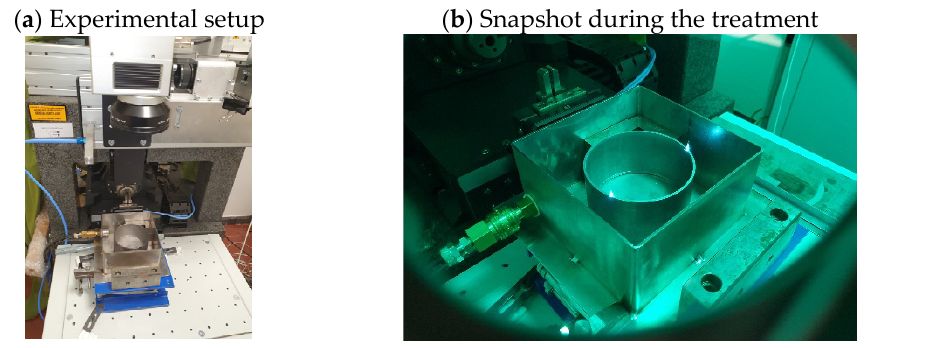
Figure 1. Femtosecond laser process. Table 4. Process